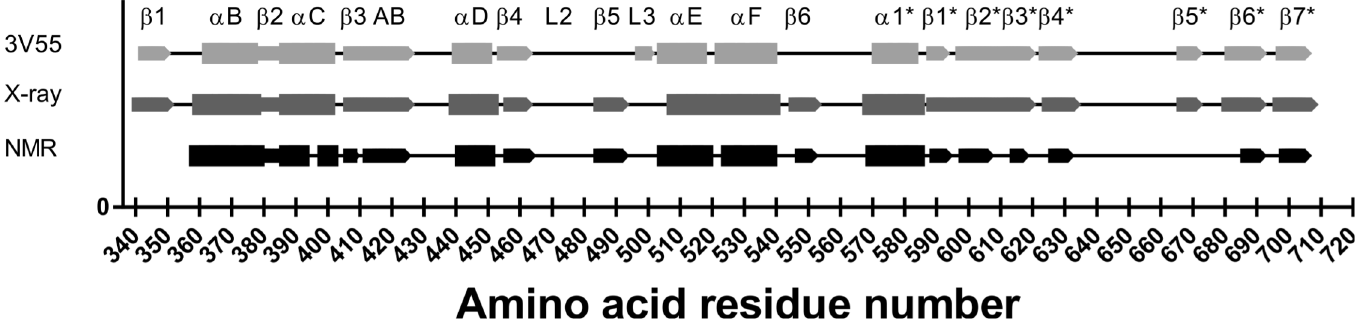
Fig 4. Estimated secondary structure from NMR experiments (in black) compared to secondary structure from the in-house X-ray structure (in dark grey) and from the published X-ray structure of apo MALT1 Casp-Ig3, PDB ID: 3V55 (in light grey). Alpha helices are indicated with a greater symbol size than the beta-sheets. β 3, β 3A and β 3B are denoted β 3 AB in the Fig. The star ( * ) indicates that the secondary structure is part of the Ig3